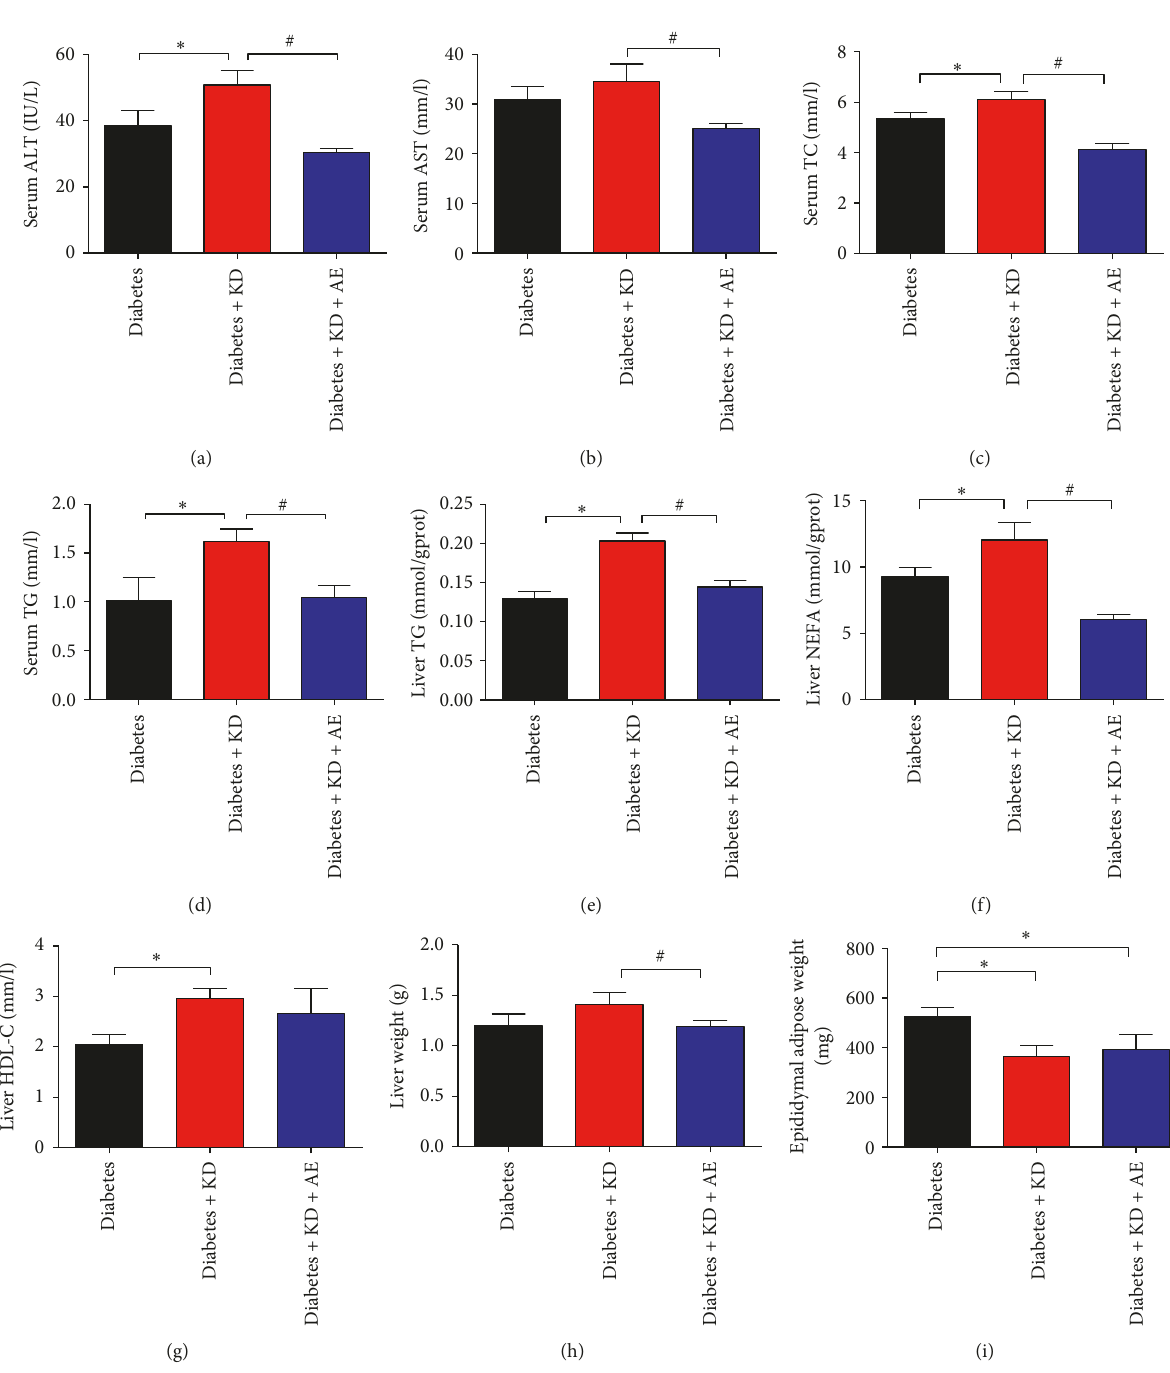
Figure 4: Aerobic exercise training improves ketogenic diet-induced metabolic complications. Aim . To evaluate the effects of ketogenic diet on metabolic parameters in diabetic mice. (a) ALT, (b) AST, (c) TC, and (d) TG levels in serum and (e) TG, (f) NEFA, and (g) HDL-C levels in mice liver of different groups were determined at the end of this experiment. (h) Liver and (i) epididymal adipose tissues are as a proportion of tissue weight per body. Data were presented as means ± SEM ( 𝑛 = 6 per group). Statistical analysis was performed with 1-way ANOVA. ∗ 𝑃 < 0.05 versus diabetic group and # 𝑃 < 0.05 versus diabetes + KD